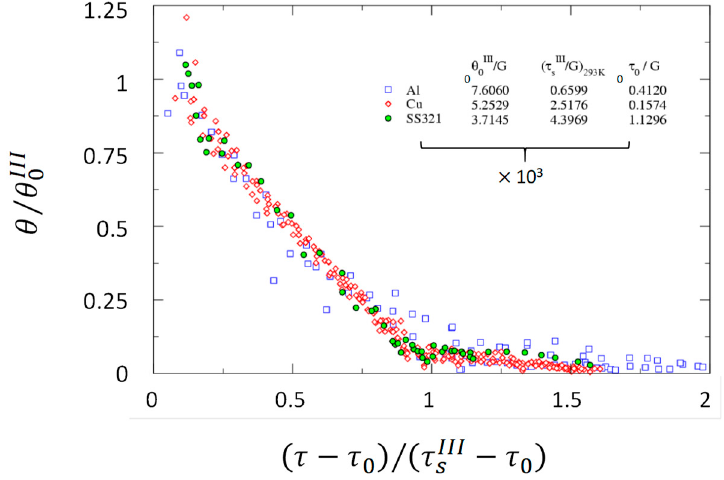
Figure 4. Torsional work-hardening rate vs. flow stress data of 99.98% Cu (77, 198, 293, 373, and 473 K), 1050 Al (77, 198, 293, and 373 K), both deformed at (cid:2013)̅(cid:4662) = 8 × 10 − 3 s − 1 and austenitic SS321 stainless steel (20 °C and 200 °C) deformed at (cid:2013)̅(cid:4662) = 2.3 × 10 − 3 s − 1 . The numerical data inserted in the figure correspond to crystallographic slip strain vs. CRSS (critical resolved shear stress) behavior; a Taylor orientation factor M = 3 should be employed to transform them into VME values (i.e., factors M and M 2 for respectively the flow stress and the SHR). Replotted results from Alberdi [11].